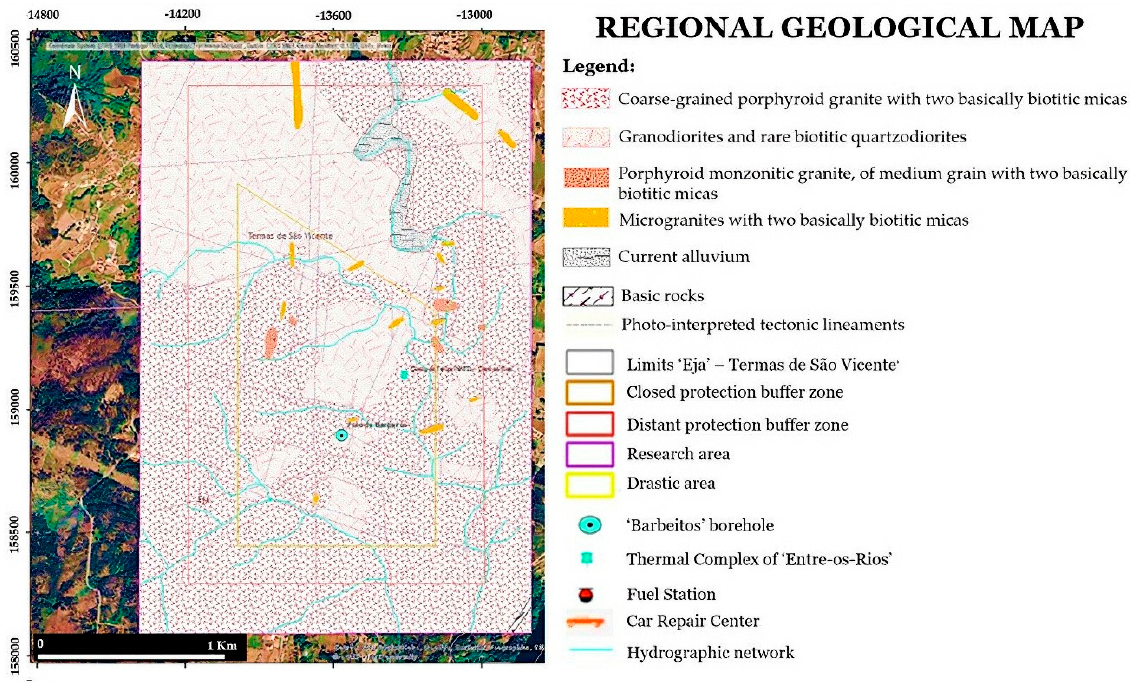
Figure 4. Regional geological outline map of the area surrounding the ‘Barbeitos’ borehole.